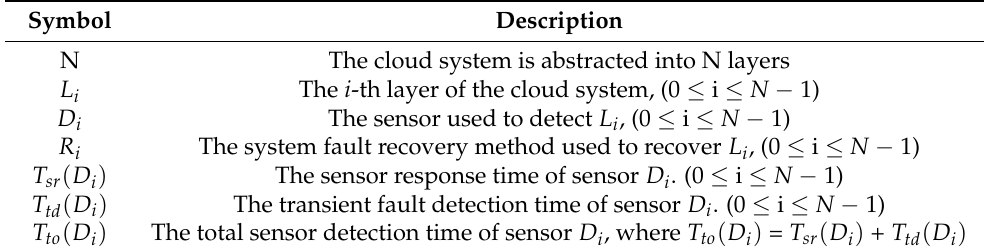
Table 1. Definition of